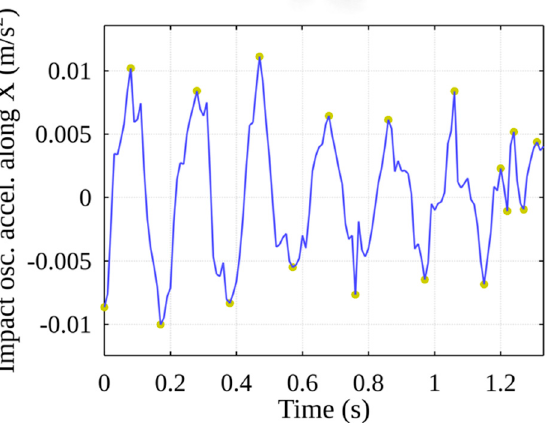
Figure 16. Stage of event detection: peak detection along the X-axis. Any peak found in the previous stage may be the result of an impact. The threshold value of the filtered signal is used to select the peaks associated with the impact: peaks with absolute values greater than the threshold indicate potential moments of events.